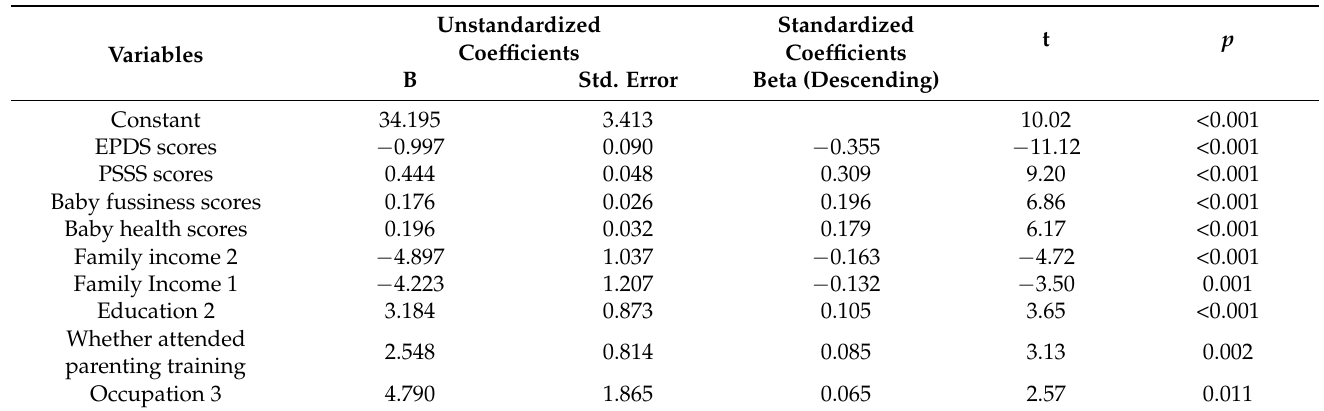
Table 3. The regression results of MSE scores at 12 weeks postpartum ( n =